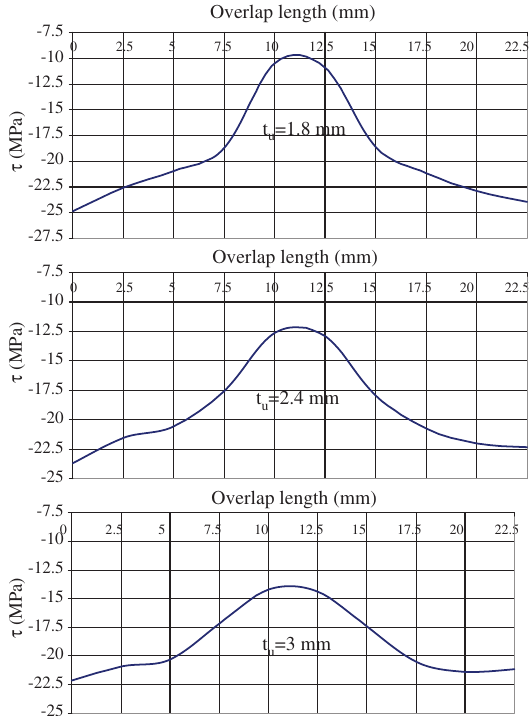
Figure 7 Shear stress distribution under elastoplastic loading for adhesive length of 2 L = 22.5 mm and adhesive thickness of t